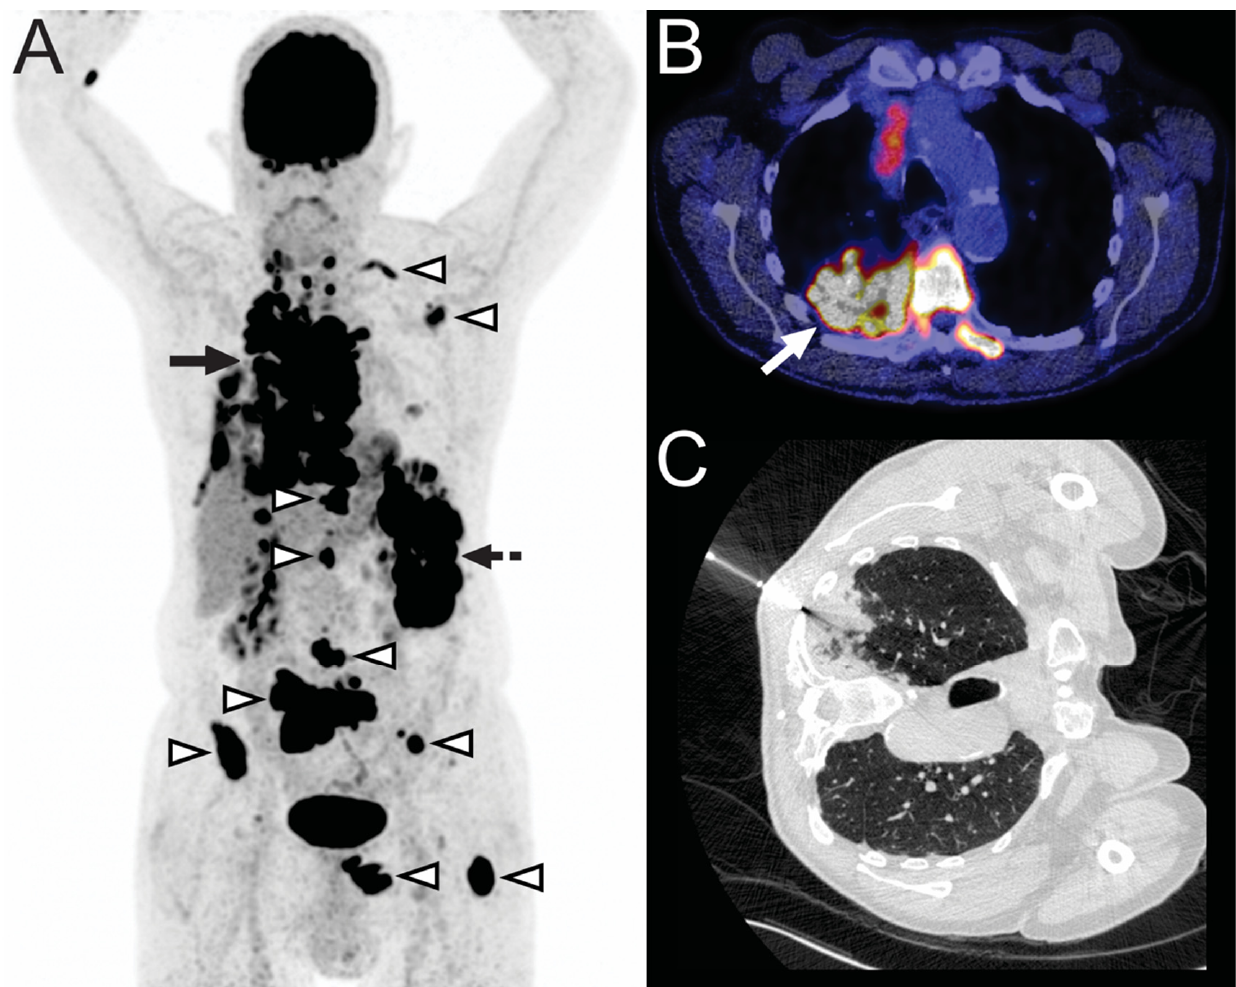
Figure 2. A 78-year-old man with a lesion in the right upper lobe, suspicious for lung cancer, was treated with radiation therapy, although no pathologic diagnosis was made. Two months later, a CT scan (not shown) suggested tumor progression. Subsequently, he was referred to our tertiary care center. FDG-PET ( A ) showed an FDG-avid mass in the right lung (continuous arrow), FDG-avid lesions in the spleen (dashed arrow), and multiple FDG-avid bone lesions (arrowheads), suspicious for metastatic disease. The mass in the right lung is also shown on fused FDG-PET/CT (( B ), arrow). CT-guided biopsy was ordered by the pulmonary oncologist for lung cancer mutation analysis. CT image ( C ) shows the biopsy needle just before tissue sampling of the mass in the right lung. Pathologic examination revealed diffuse large B-cell lymphoma and no lung